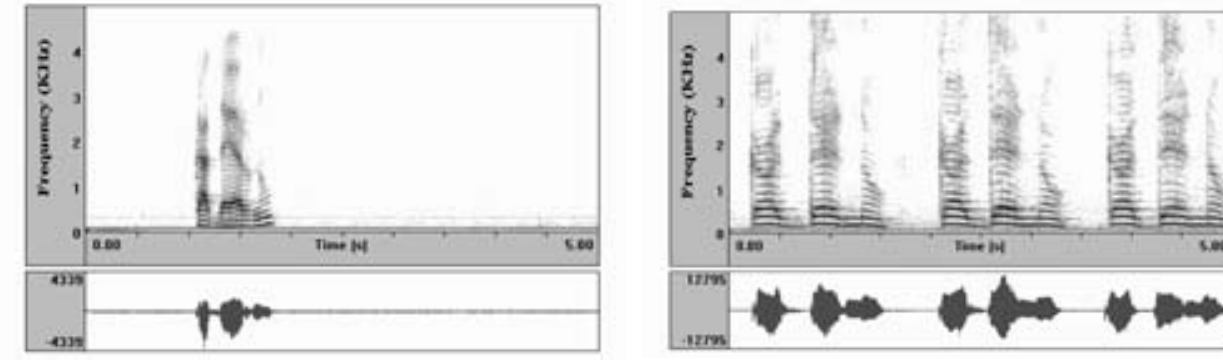
Figura 1a. Uma emissªo da palavra caderno pelo sujeito sem anartria. Cada mancha corresponde a uma s(cid:237)laba da palavra.